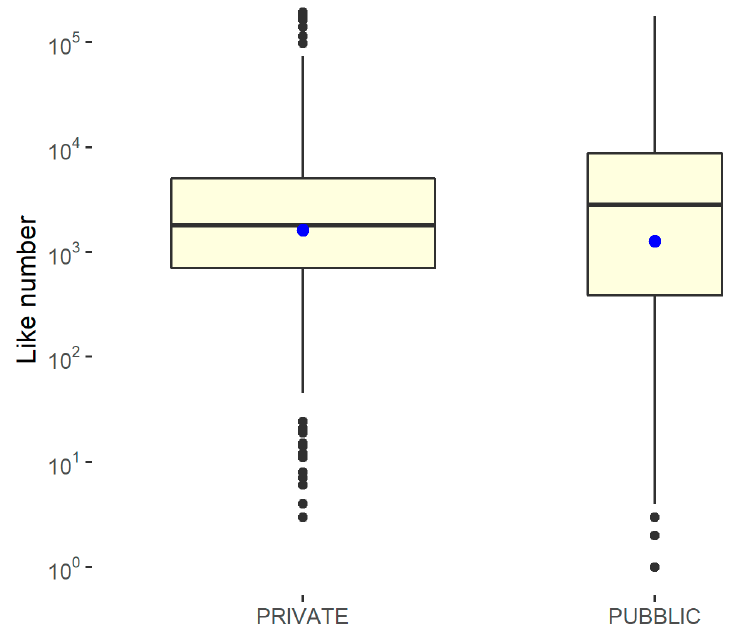
Figure 9. Kruskal–Wallis rank-sum test to determine the differences in the number of likes for the public/private hospitals. Kruskal–Wallis chi-squared = 0.679, df = 1, and p -value = 0.41 (no significant difference).